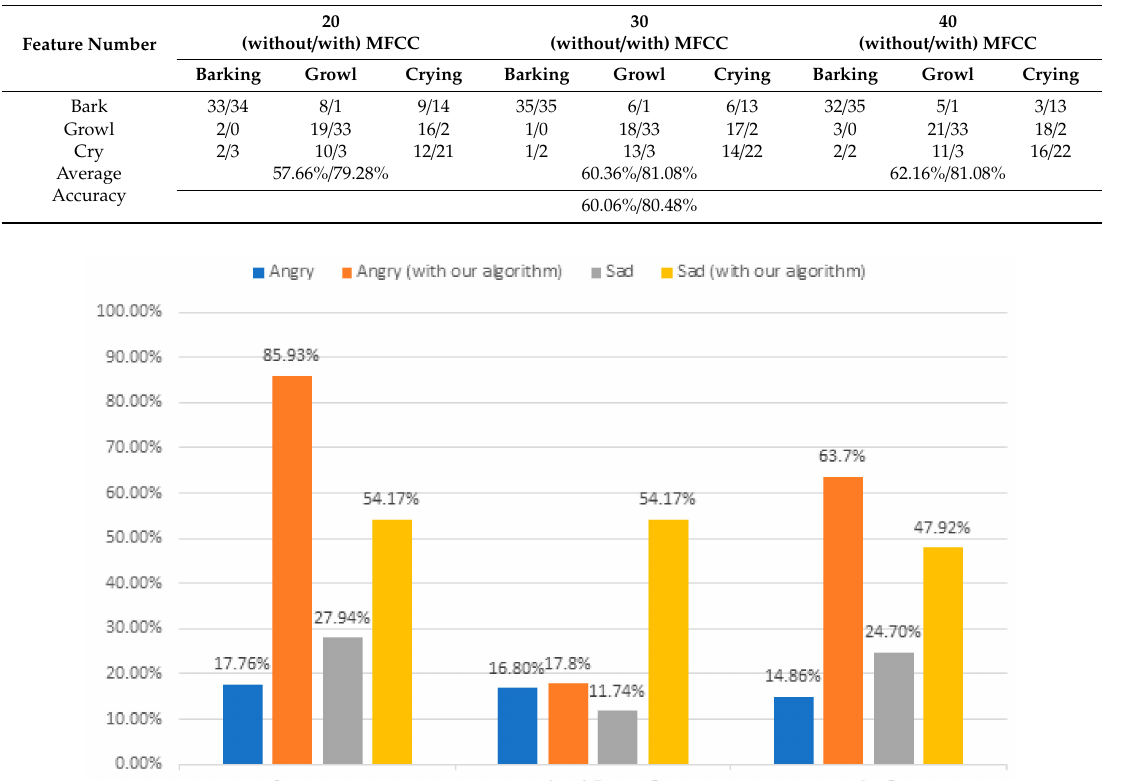
Table 2. The accuracy of the K nearest neighbor (KNN) audio identification model.